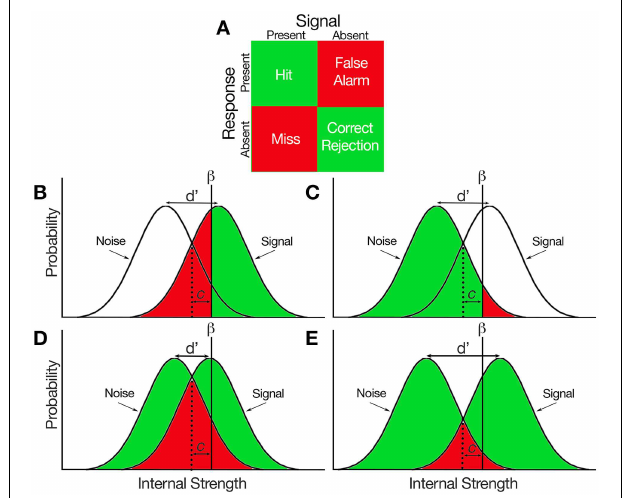
FIGURE 1 | Hypothetical representations of the signal and noise probabilities distributed within a decision-maker. (A) Response matrix of all signal-response combinations that can be made in a binary decision task. Green indicates correct decision, red indicates incorrect decision. (B) Proportions of hits and misses represented under the signal distribution. β reflects the subject criterion, c reflects bias, and d ′ reflects sensitivity which represents the difference in position between the two distributions. (C) Proportions of false alarms and correct rejections represented under the noise distributions. (D) A condition which hypothetically reflects low subject sensitivity. When the distributions are closer together (i.e., d ′ is smaller), the difference between the proportion of hits and false alarms is lower. (E) A condition which reflects high subject sensitivity. When the distributions are farther apart (i.e., d ′ is larger), the difference between the proportion of hits and false alarms is